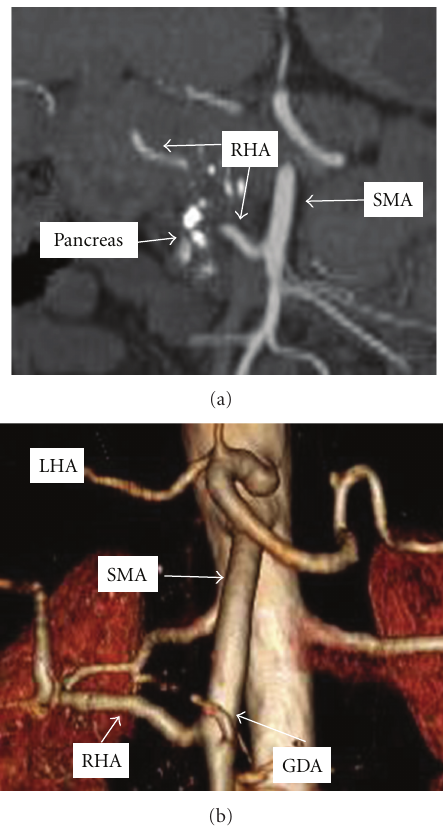
Figure 2: Coronal computed tomography reconstruction of mesen- teric arterial vasculature in Case 2. GDA: gastroduodenal artery, LHA: left hepatic artery, RHA: right hepatic artery, SMA: superior mesenteric artery, Pancreas: calcified head of the pancreas.